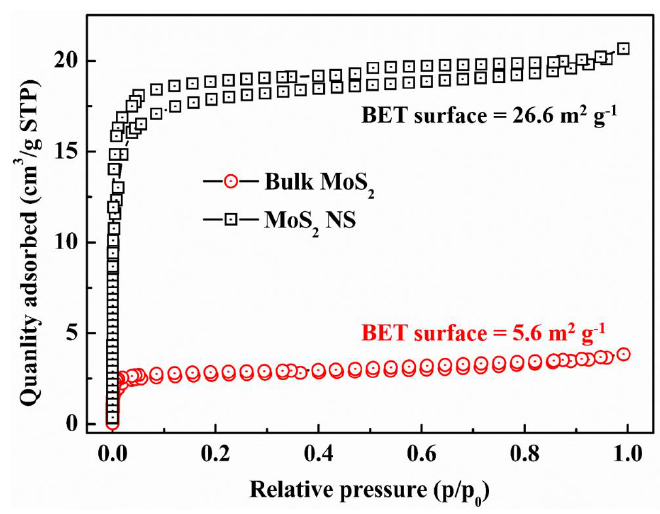
Figure 3. Brunauer–Emmett–Teller ( BET) N 2 isotherms of the bulk MoS 2 and MoS 2 NS. Processes 2020 , 8 , x FOR PEER REVIEW